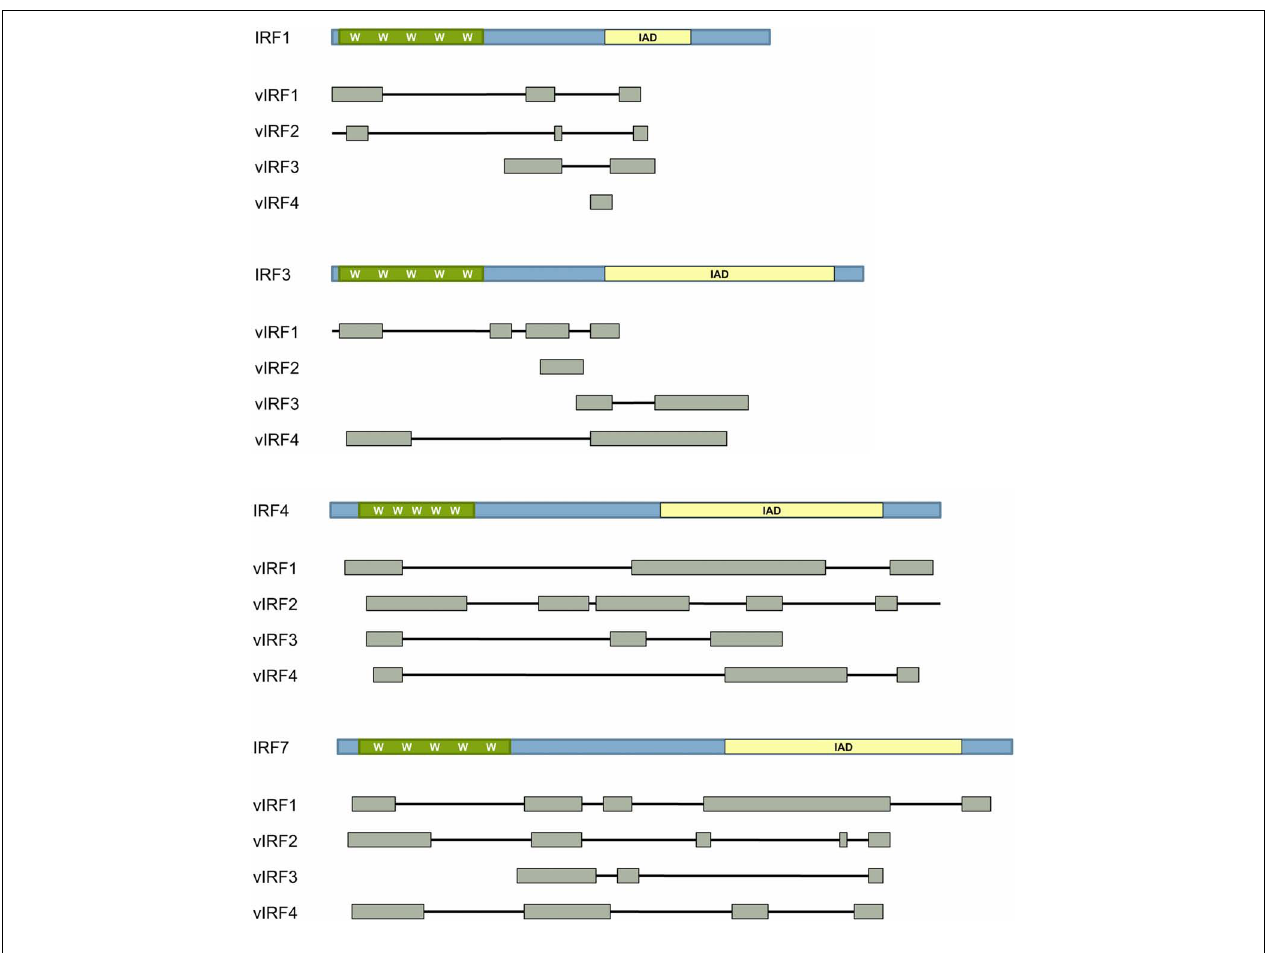
FIGURE 3 | Homology of vIRFs with cellular IRFs. Cellular interferon regulatory factors (IRFs) are composed of a DNA-binding domain (DBD; green) and a regulatory domain (blue).The DBD of cellular IRFs is defined by 5 tryptophan (W) residues. Cellular IRFs may also contain an IRF-association